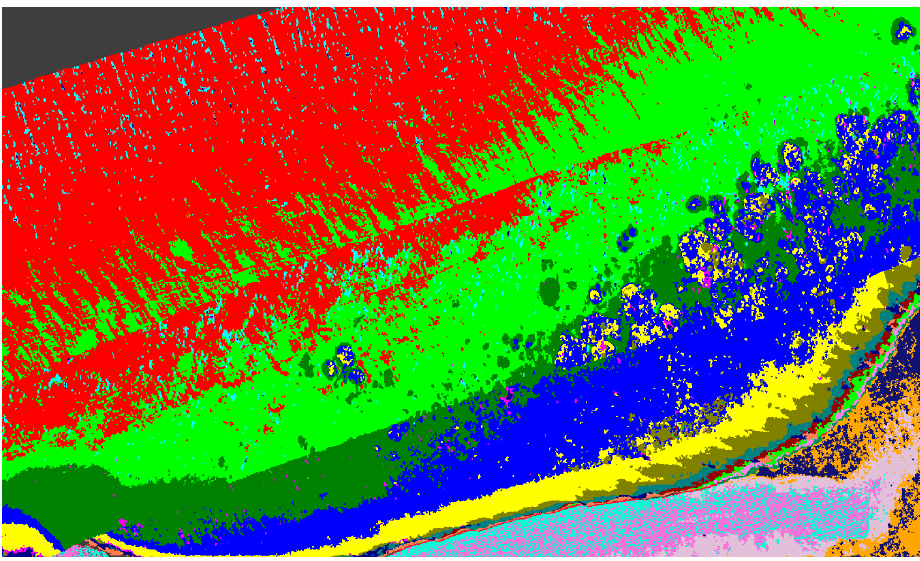
Figure 20. Unsupervised material classification for Pandora Reef.